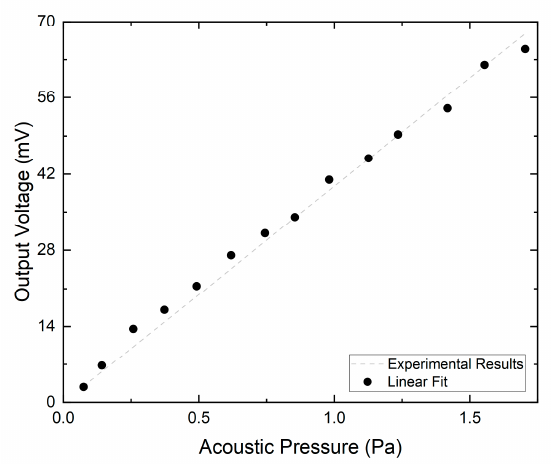
Figure 9. Output voltage of the fiber sensor for the different applied acoustic pressure, at the frequency of 25 kHz.